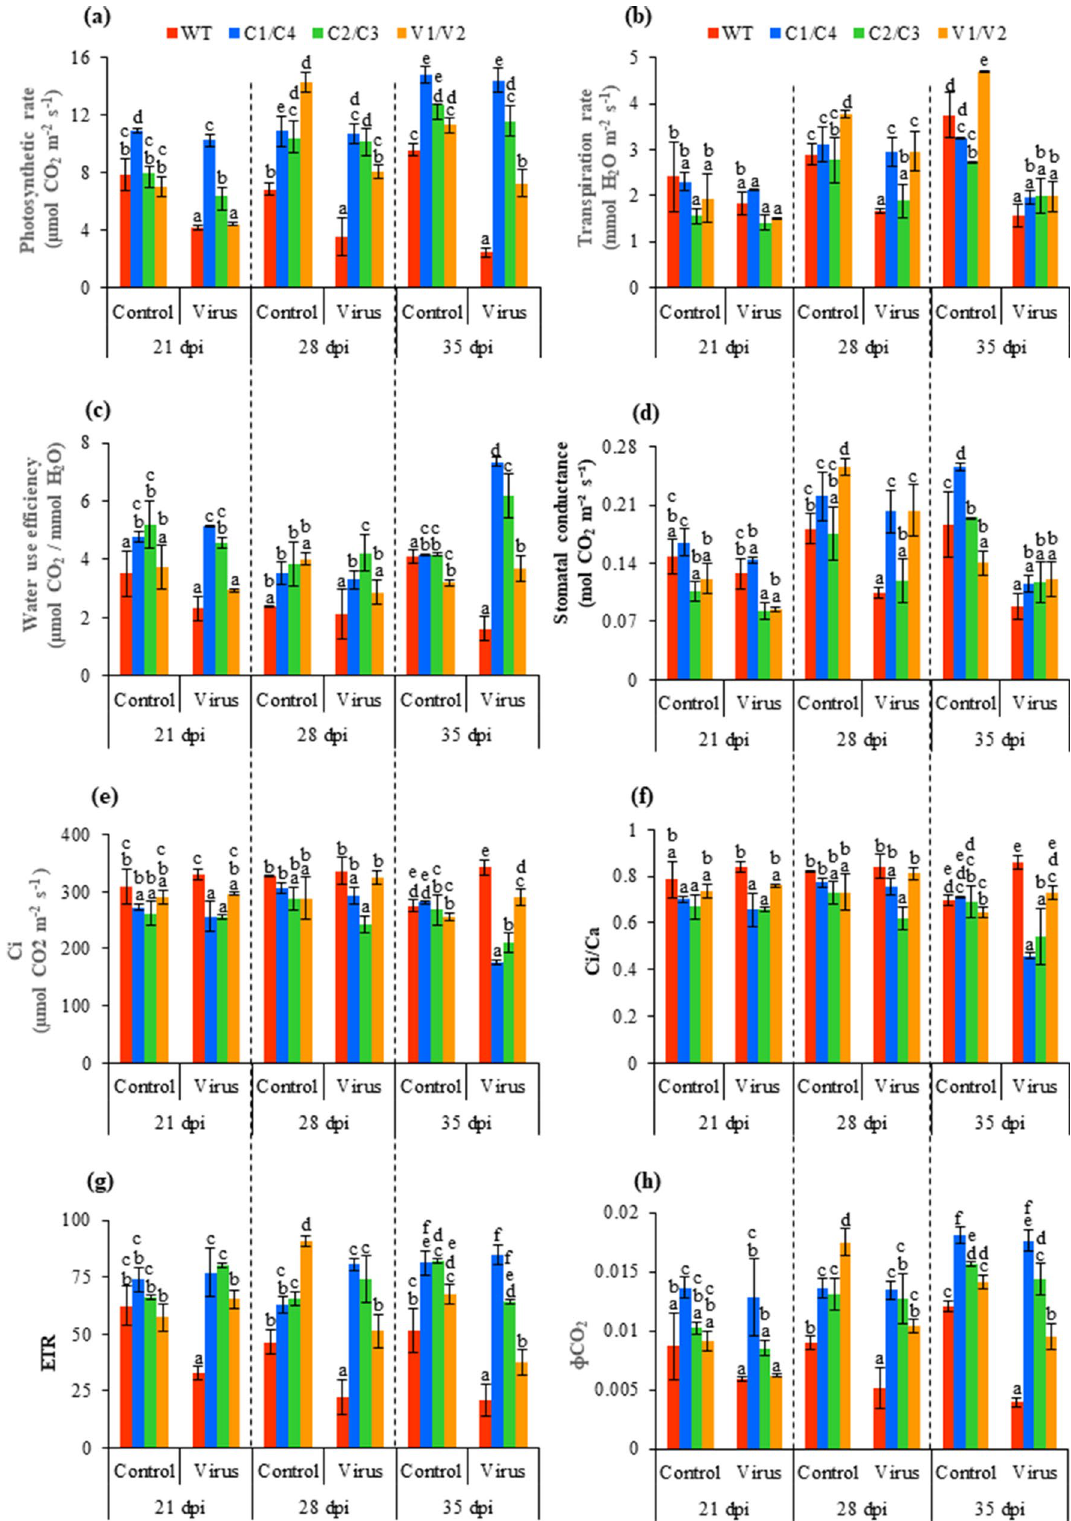
Figure 3. Analysis of gas exchange related photosynthesis parameters of WT, C1/C4, C2/C3 and V1/V2 amiRNA plants with and without JLCuGV agroinfiltration ( a ) Photosynthesis rate, ( b ) Transpiration rate, ( c ) Water use efficiency, ( d ) Stomatal conductance, ( e ) Ci, ( f ) Ci/Ca ratio, ( g ) ETR and ( h ) ΦCO 2 . Values are represented as means ± SD (n = 3) and marked with different alphabets to indicate a significant difference as determined by Tukey test at P ≤ 0.05